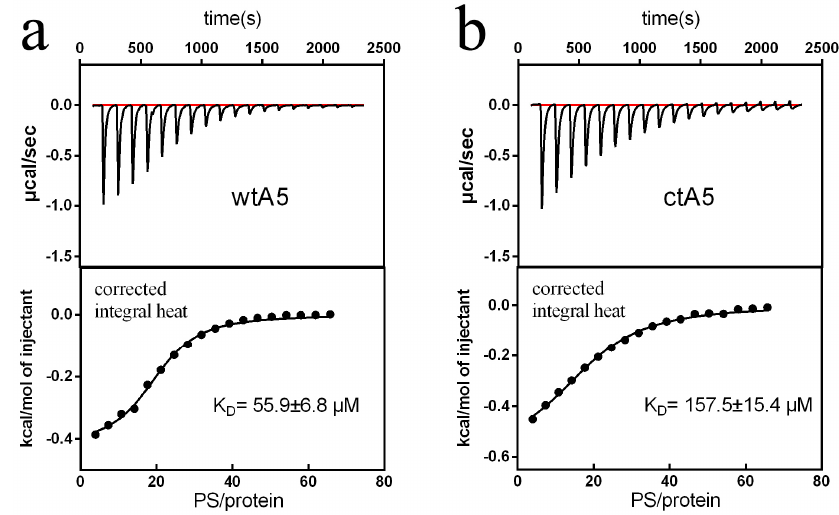
Figure 5. Titration of wtA5 and ctA5 with liposome in the presence of calcium. ( a ) Titration of 30 μ M wtA5 with 25 mM POPS:POPC liposome. ( b ) Titration of 30 μ M ctA5 with 25 mM POPS:POPC liposome. The top of each profile shows the raw ITC data output during titration. The bottom of each profile represents the experimental points and the best fit. The points are derived from the raw data, and the heat of dilution was subtracted using the blank control of buffer titrated with liposome. The solid line at the bottom of each profile represents the best fit. Table 2. Parametric analysis of liposome